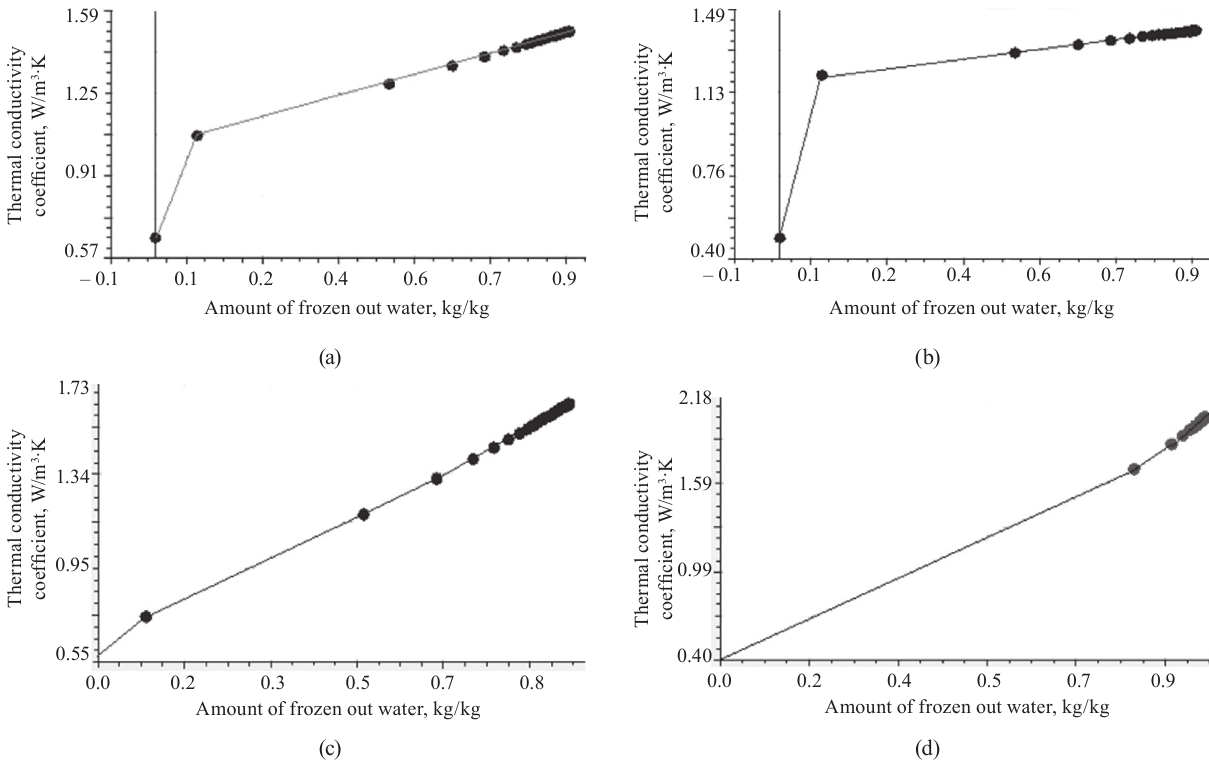
Figure 2 Relation between thermal conductivity coefficient and the amount of frozen out water for: (a) squid trunk; (b) milt of herring; (c) octopus skin; (d)